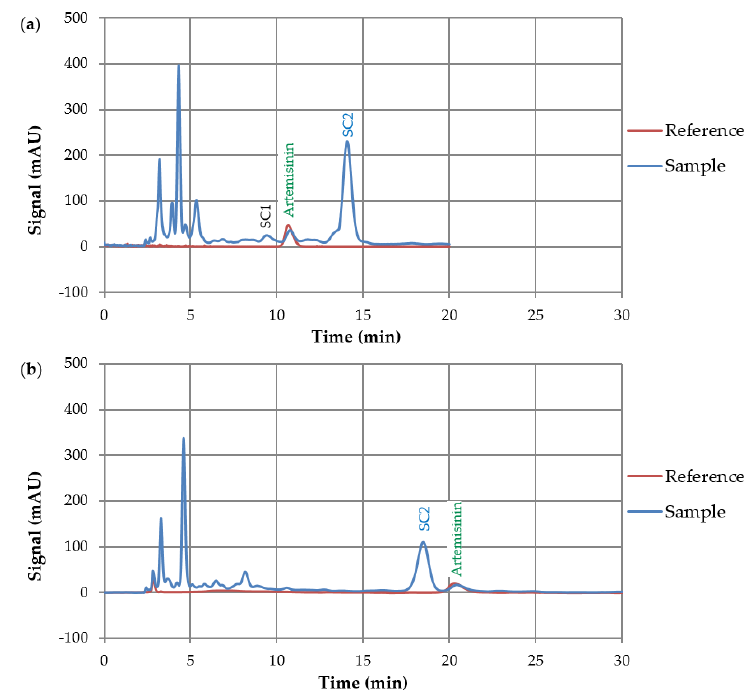
Figure 8. Comparison of isocratic runs with n -hexane/ethyl acetate on LiChrospher Si60 ( a ) 85/15 vol % and ( b ) 90/10 vol %, detection at 254 nm.